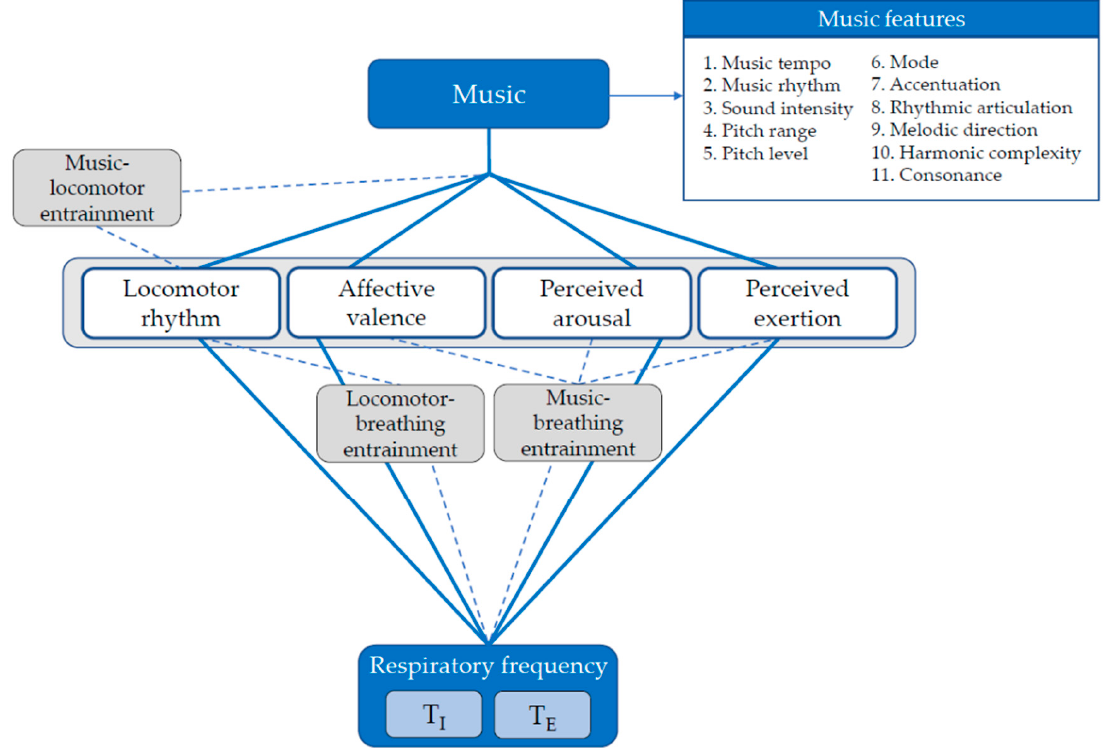
Figure 2. Operational framework providing information on the tools to use to investigate the mechanisms underlying the effect of music on f R and its subcomponents. The grey rectangular box highlights how the tools reported inside should be evaluated together for providing information on the magnitude of the inputs regulating f R . For instance, the combined evaluation of affective valence and perceived arousal provides insight into the emotions experienced during exercise. The three entrainment tools proposed in this study and their potential connections are depicted. Note that each music track can be described by the means of 11 features. The features from 1 to 5 can be quantified objectively and can therefore be easily controlled when selecting music for experimental purposes. The features from 6 to 11 are more influenced by subjective perception of music. See Gomez and Danuser [11] for detailed information on the music features.